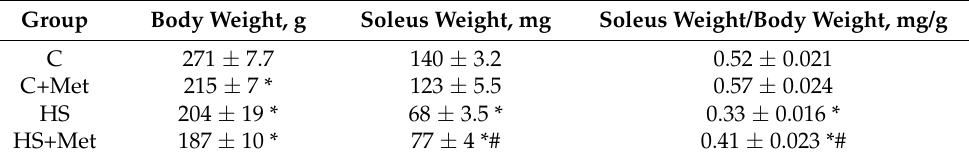
Table 2. Changes in body weight and soleus muscle